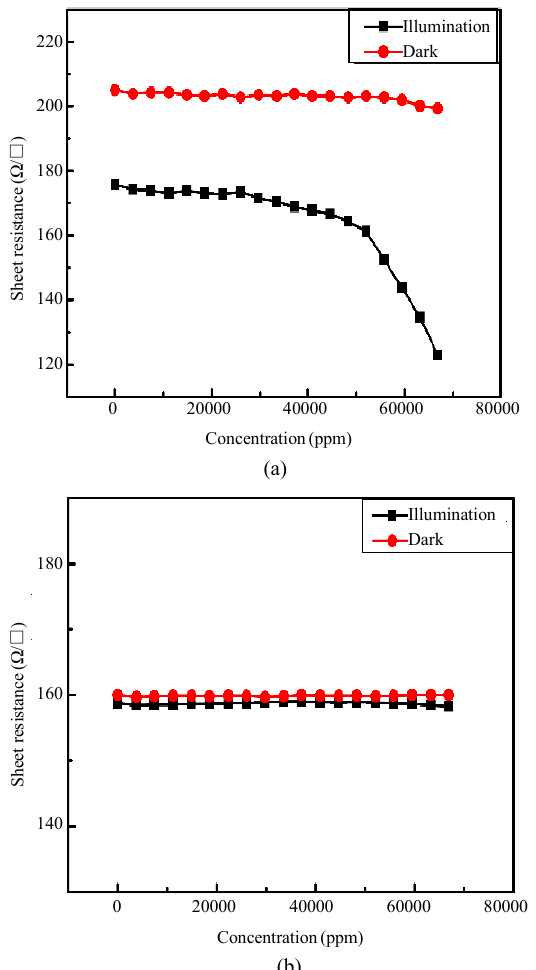
Fig. 5 Sheet resistance as a function of the ethanol concentration: (a) the coupling sample and (b) the reference